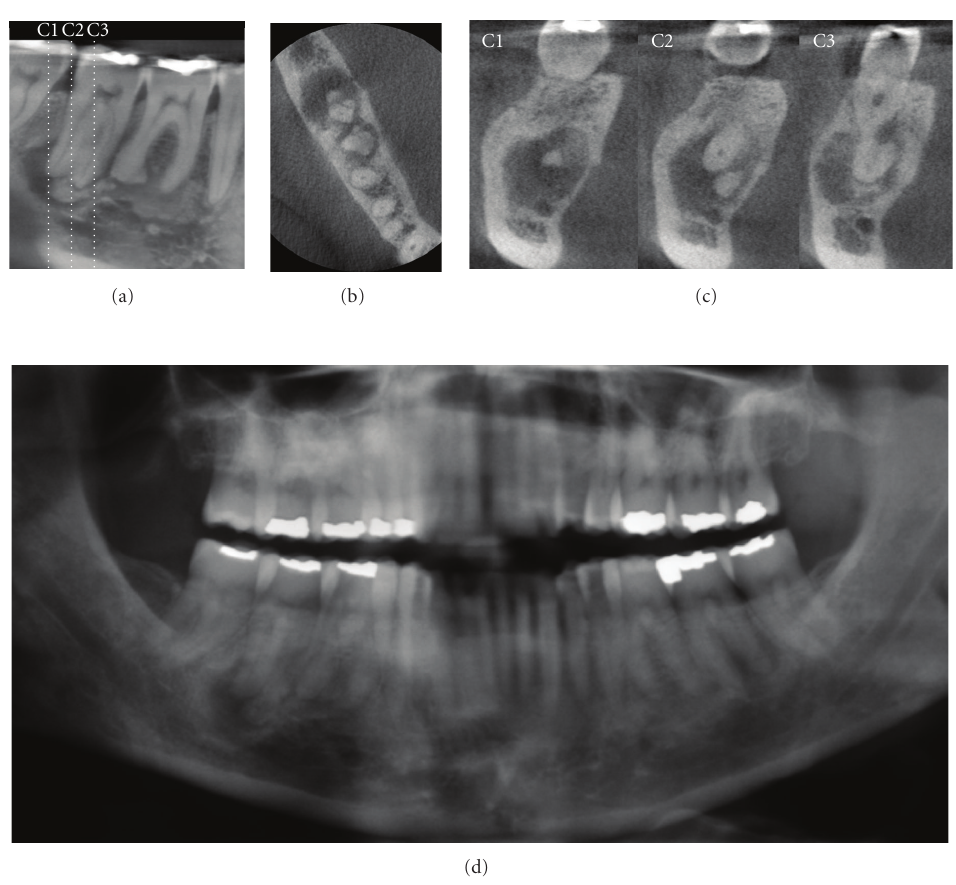
Figure 2: A 52-year-old Caucasian female was referred for assessment of multiple periapical areas associated with the mandibular right first and second molars. Curved planar (a), axial (b), and correlated multiple cross-sectional (c) images are shown. There are areas of mixed central opacity and peripheral radiolucency associated with the apices of the teeth; however no expansion, tooth resorption, or displacement is evident. Hypercementosis is observed on the distal root of the first molar. On clinical examination, all teeth in this quadrant tested vital. Based on a working diagnosis of florid cemento-osseous dysplasia, an additional digital panoramic radiograph ((d) cropped panoramic image) was performed and revealed similar bony patterns in the left posterior maxilla and mandible. Management of this patient comprised a 6-month recall comparison of focused CBCT images to judge the progression of the